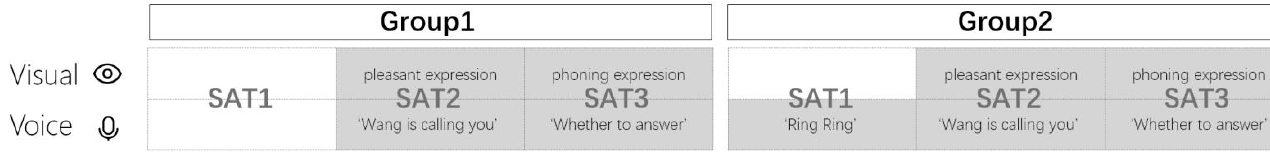
Figure 2. Telephone task experimental group setup. The gray choices represent information that appeared at a certain level in the experimental group, and the white choices represent that there is no information in that level.